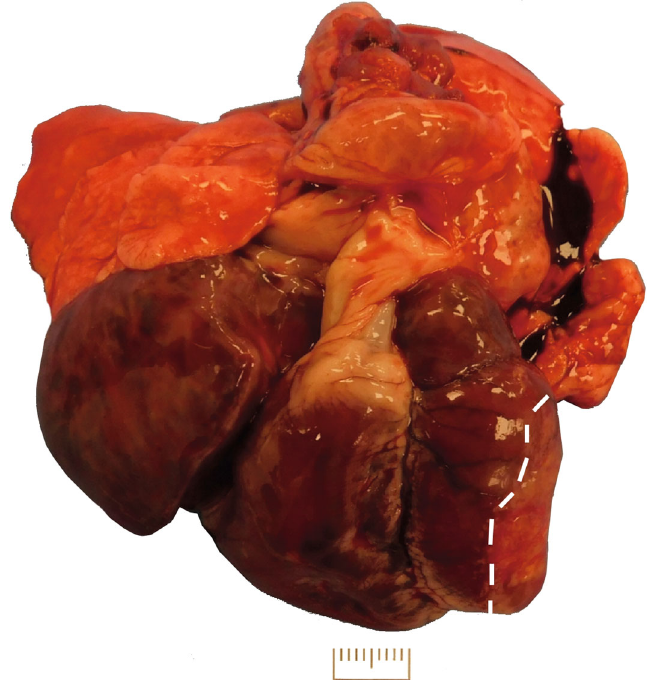
Figure 2: Gross image of the heart and lungs — caudal view of the heart. The left ventricle had a focally extensive depressed fi rm white area encompassing approximately half of the ventricular free wall (outlined in white dashes). Scale bar = 1